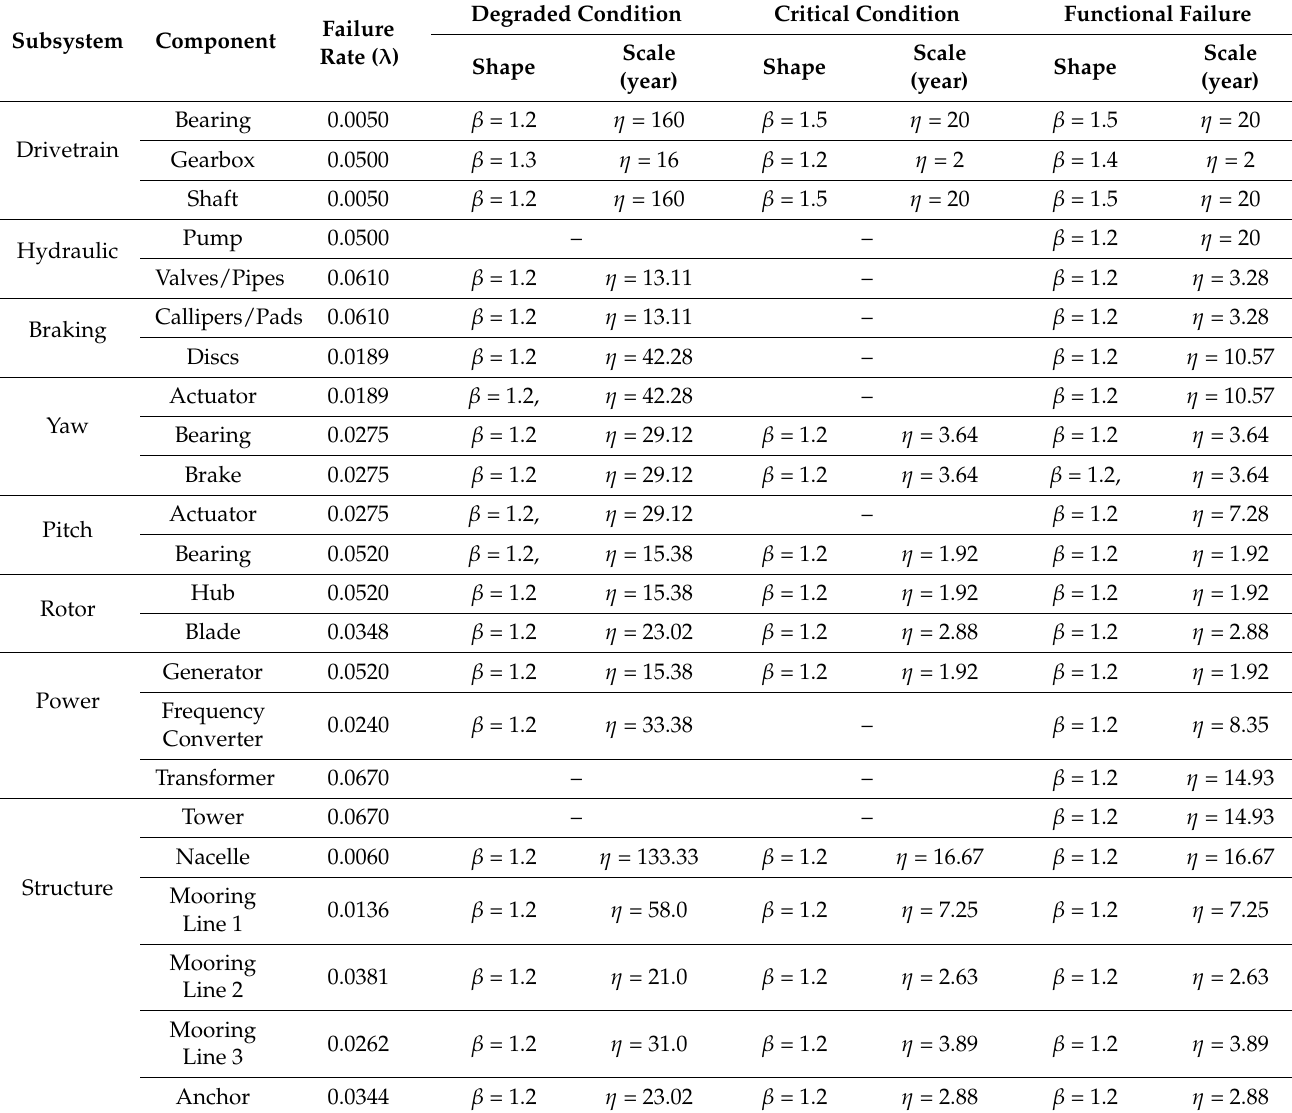
Table A2. Weibull distribution parameters for degradation process of FOWTs [37,41,42].